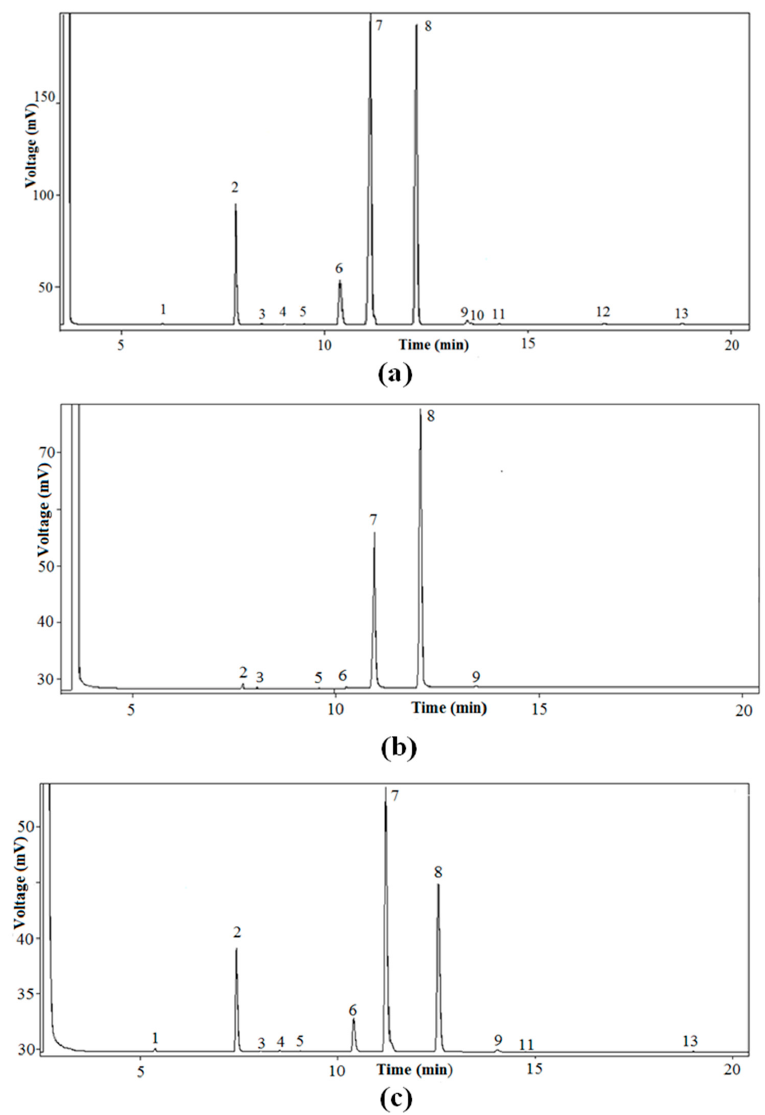
Figure 2. Characteristic high-resolution gas chromatography (HRGC) profiles of pumpkin ( C. maxima , var. Berrettina) seed oil samples. ( a ) Fatty acid methyl esters (FAME) of TAG fraction; ( b ) FAME of monoacylglycerol (MAG) fraction; ( c ) FAME of PA fraction. 1. Myristic acid, 2. Palmitic